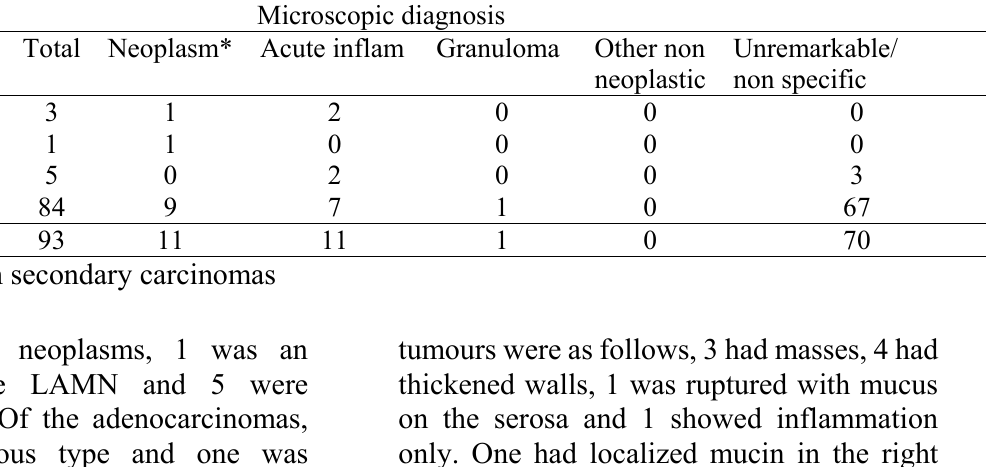
Table 3 . Correlation of gross appearances of appendices with microscopic features